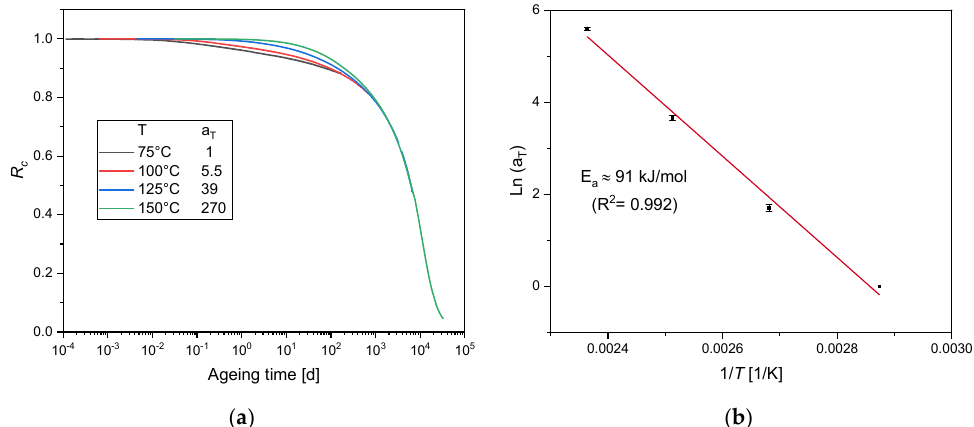
Figure 9. ( a ) TTS of R C at the four different temperatures with the reference temperature of 75 °C and corresponding shift factors. ( b ) Arrhenius plot of shift factors a T .